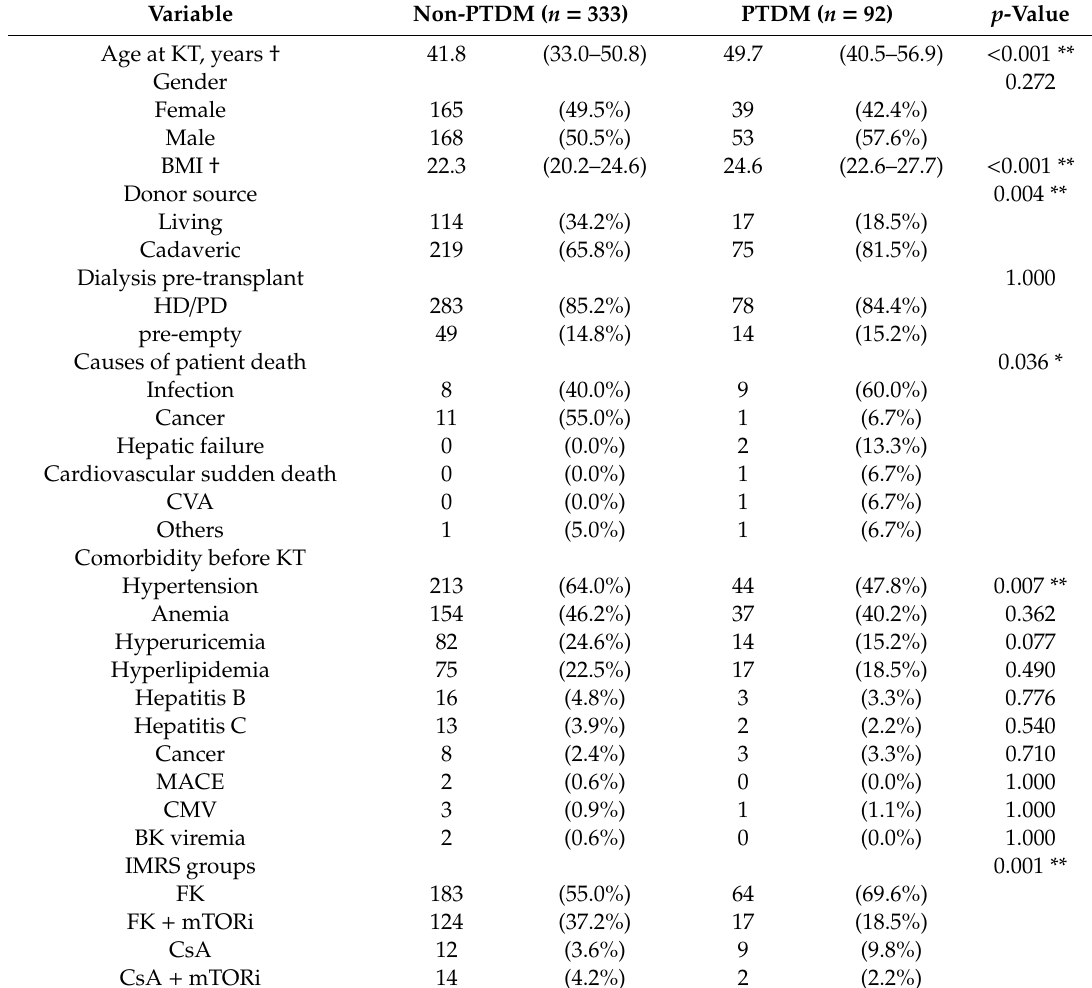
Table 1. Characteristics of the kidney transplantation study